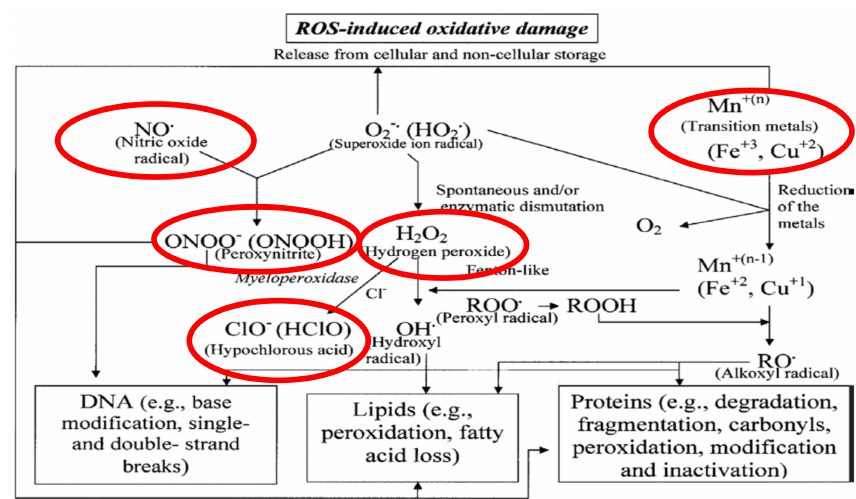
Figure 1. Reproduced with permission from [6] published by Sage Journals, 2002.